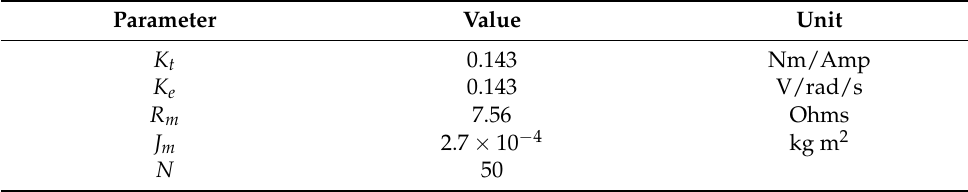
Table 1. Parameters of the ISP